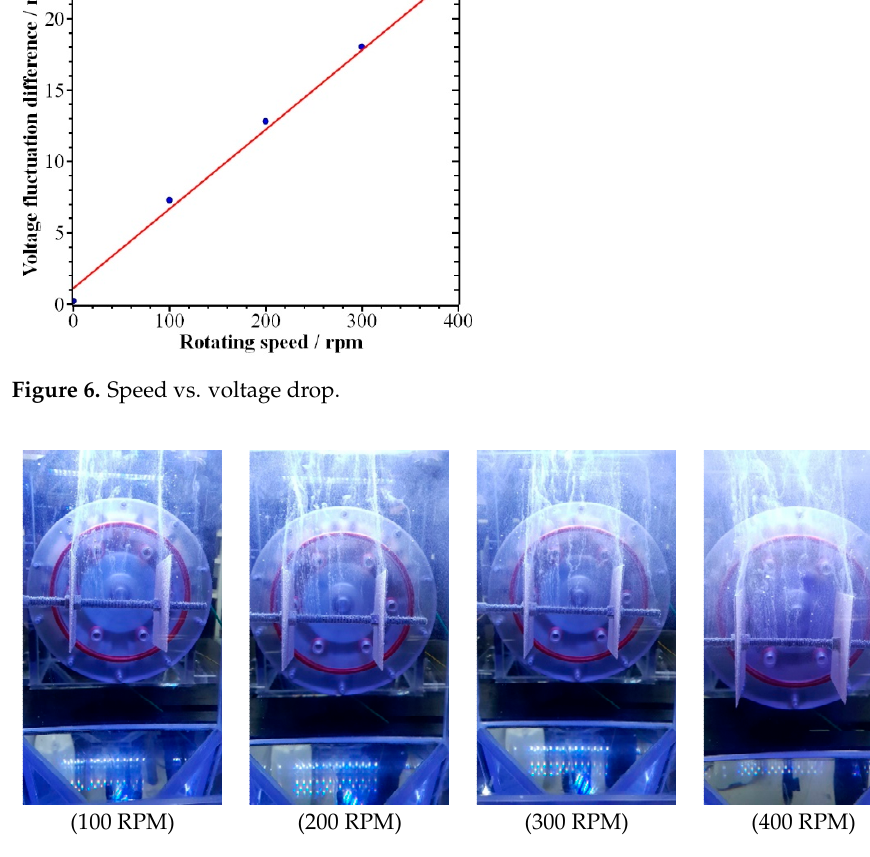
Figure 7. Hydrogen generation at different rotational speeds.